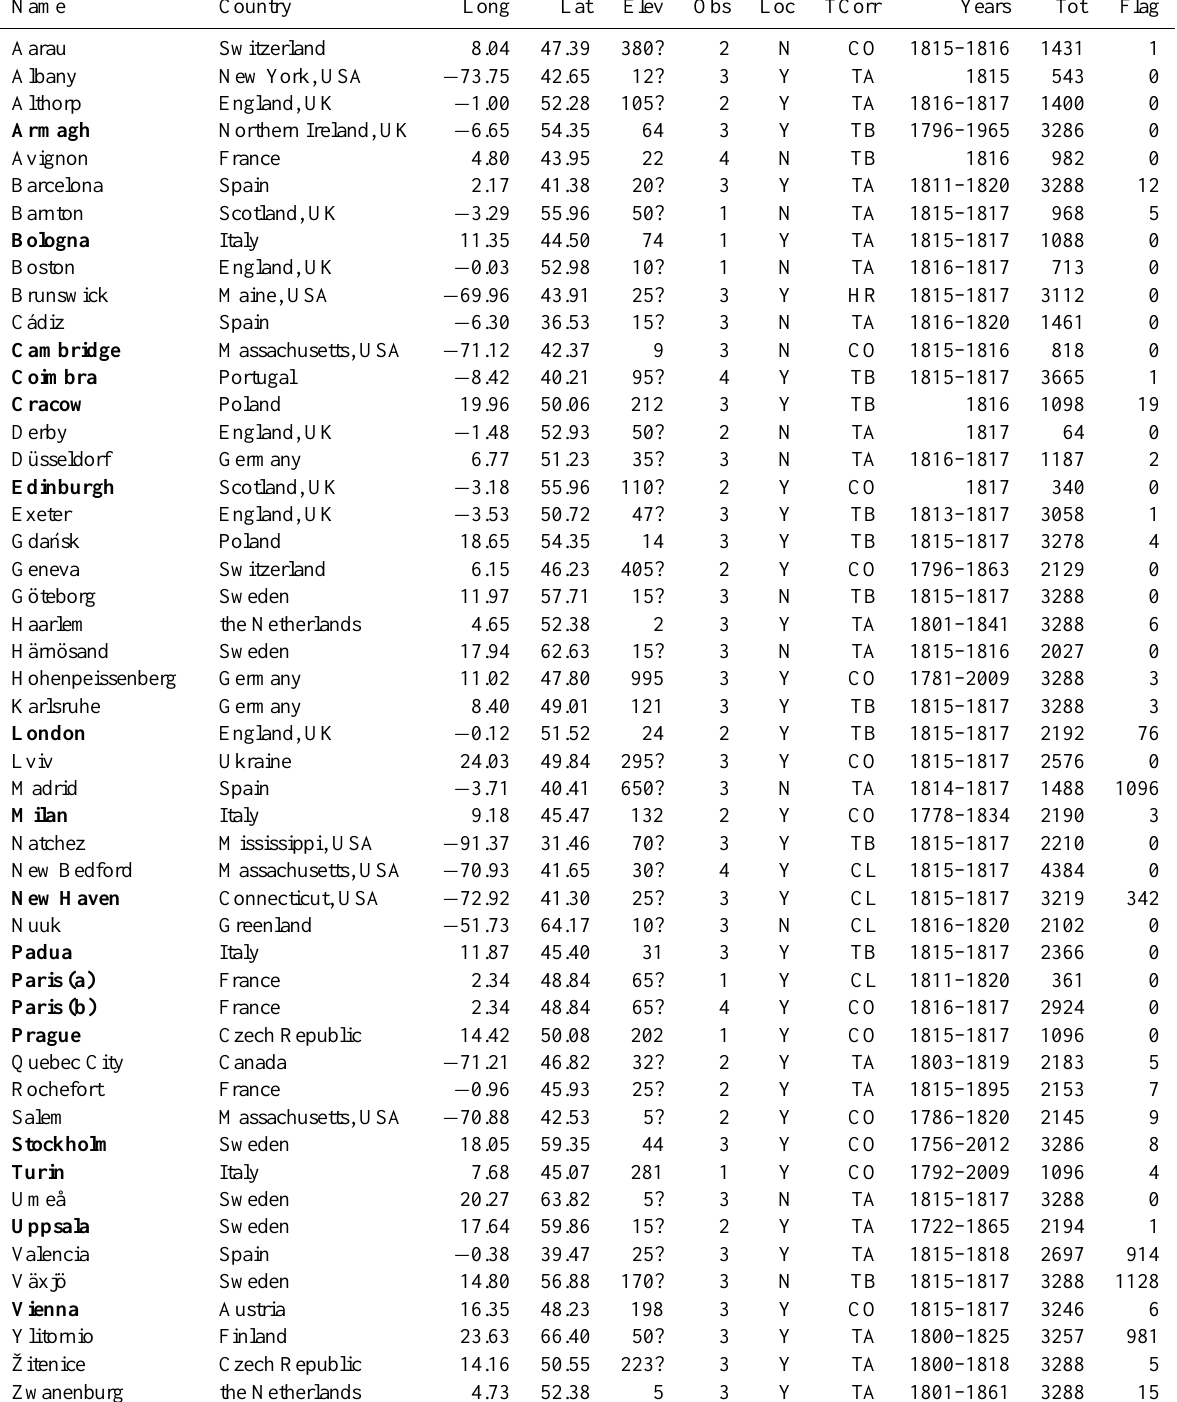
Table 1. List of land stations included in the collection, in alphabetical order. Observatories managed directly by scientific organisations are written in bold. Metadata refer to the period 1815–1817. Abbreviations: Long – longitude in degrees east; Lat – latitude in degrees north; Elev – elevation of the barometer in metres a.s.l. (rounded to the nearest full metre); Obs – typical number of pressure observations per day; Loc – exact location (within 100m) from metadata (Y – available; N – not available); TCorr – data used for temperature correction (TB – temperature of the barometer; TA – outside air temperature; CL – outside temperature climatology; CO – observations already corrected for temperature; HR – heated room (constant temperature of 18 ◦ C assumed)); Tot – number of pressure observations in 1815–1817; Flag – number of flagged observations after quality control. A question mark indicates estimated